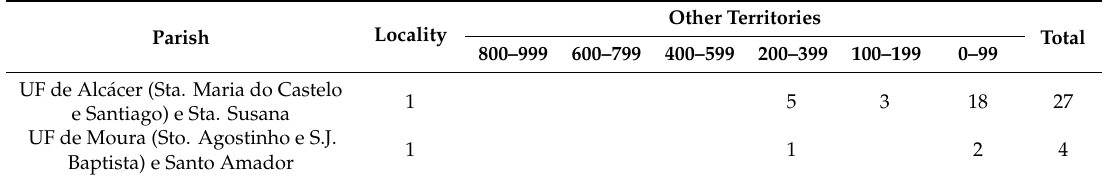
Table 9. Number of other territories in APU (TIPAU) and Code 3 (DEGURBA) parishes, according to their population size.